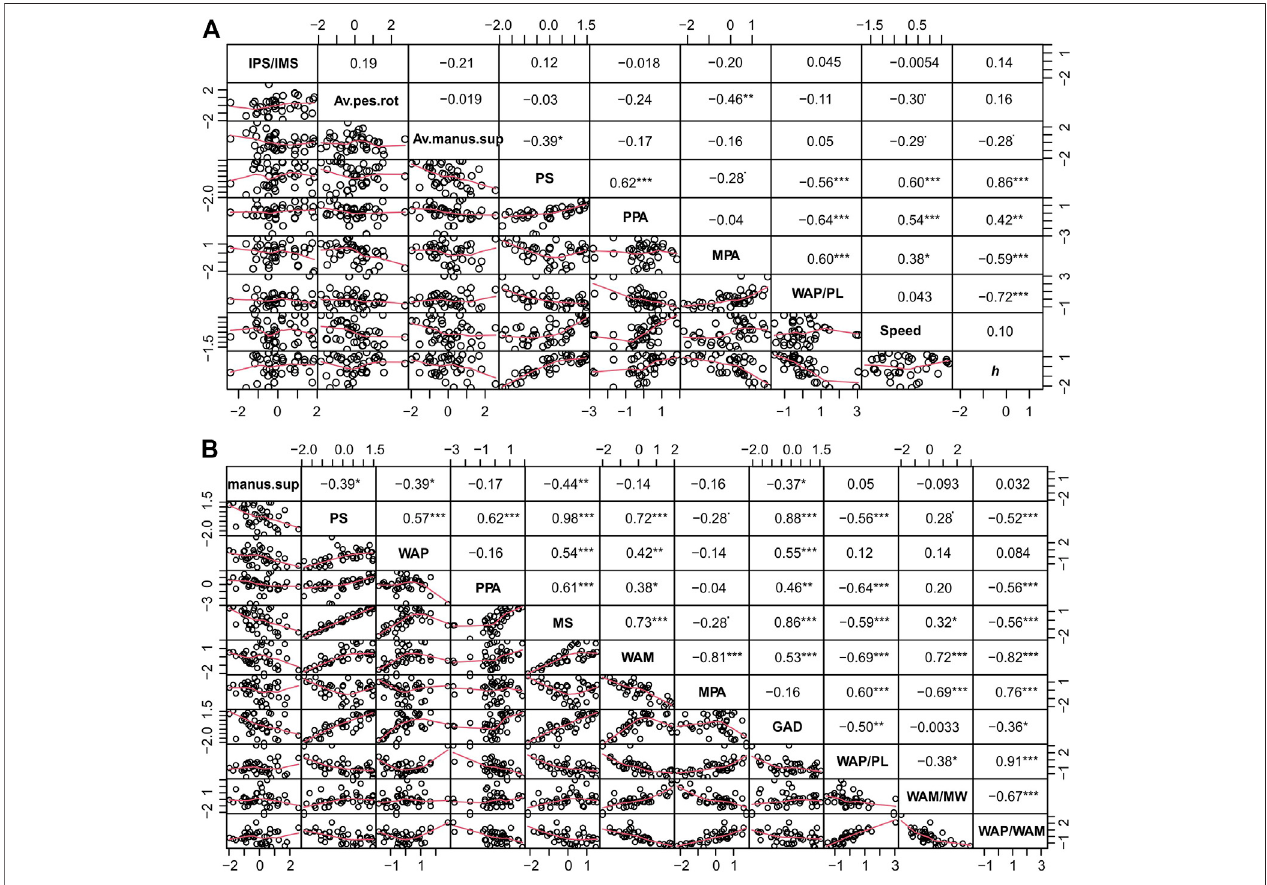
FIGURE 4 | (A,B) Correlation matrices for TCH track/trackway parameters showing pair-wise scatter plots and correlation coef fi cients; p -values ( < 0.001, < 0.01, < 0.05,0.1,1)correspondtosymbols[ “ *** ” , “ ** ” , “ * ” , “ . ” , “” ]).Acronymsusedaspertext.Av.pes.rot:averagepesrotation;Av.manus.sup.manussup.:manussupination.